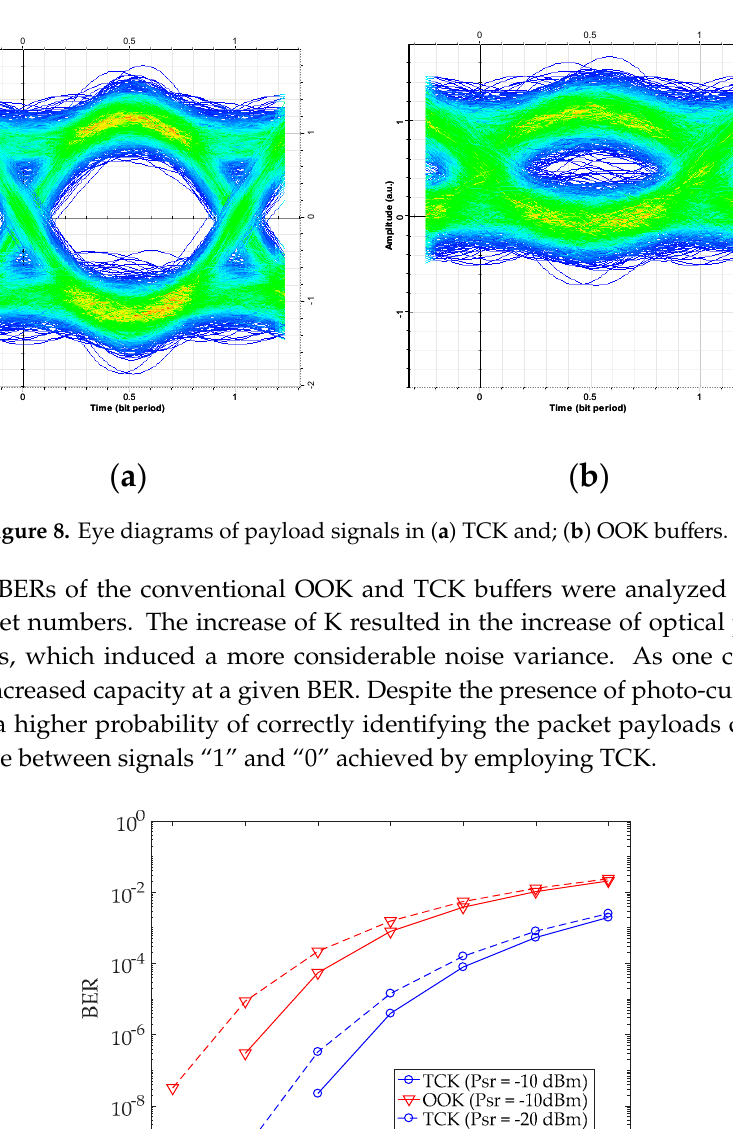
Figure 8. Eye diagrams of payload signals in ( a ) TCK and; ( b ) OOK buffers.